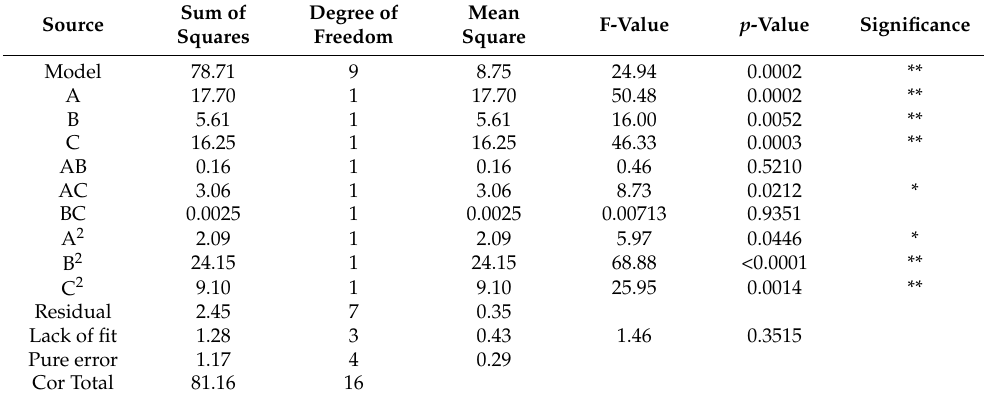
Table 7. Variance analysis of regression model.